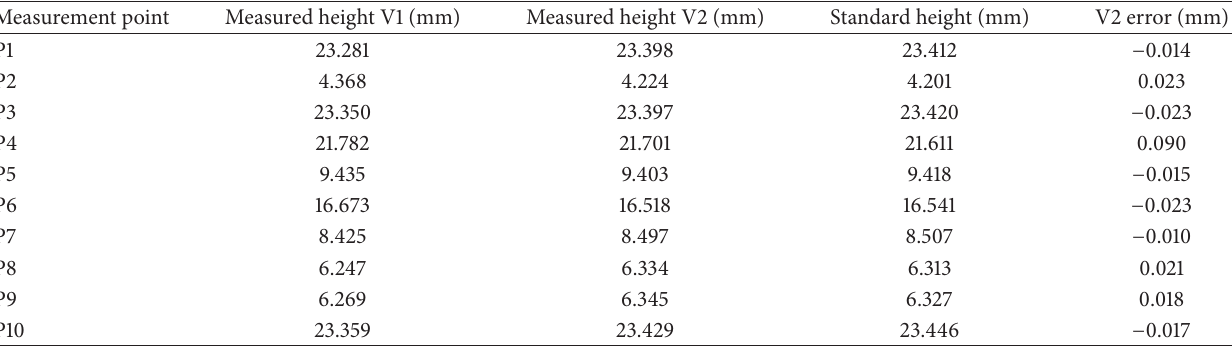
Figure 7: Light stripe center extraction comparison. Table 2: Comparison of the measurement